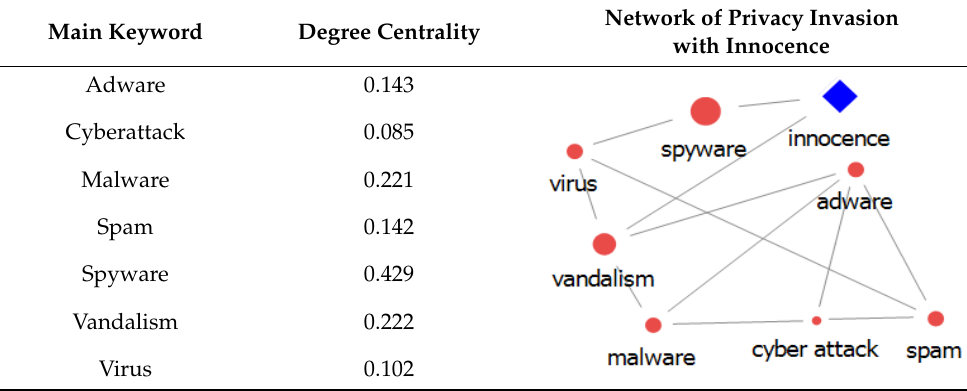
Table 6. Degree Centrality of Innocence.